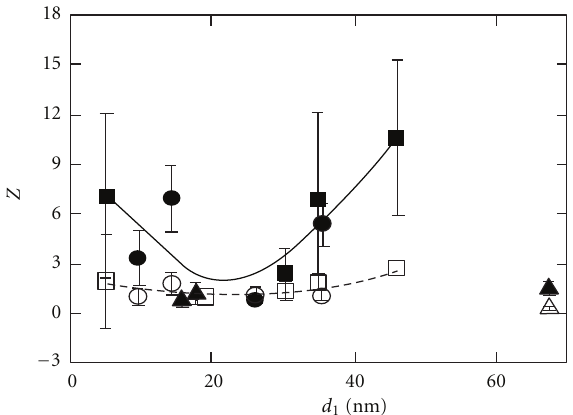
Figure 9: Normalized specific lipid oxidation ( Z ) for three types of NP. Circles are SiO 2 , triangles are Al 2 O 3 , and squares are TiO 2 . Open symbols are 100mg/L. Solid symbols are 1000 mg/L. Line is fitted 4-parameter Gaussian equation (9) in SigmaPlot ver. 9.01. Experimental conditions: initial algae concentration = 1 . 4 ± 0 . 9 × 10 6 cell/mL, test duration = 4 days, and initial test volume = 200